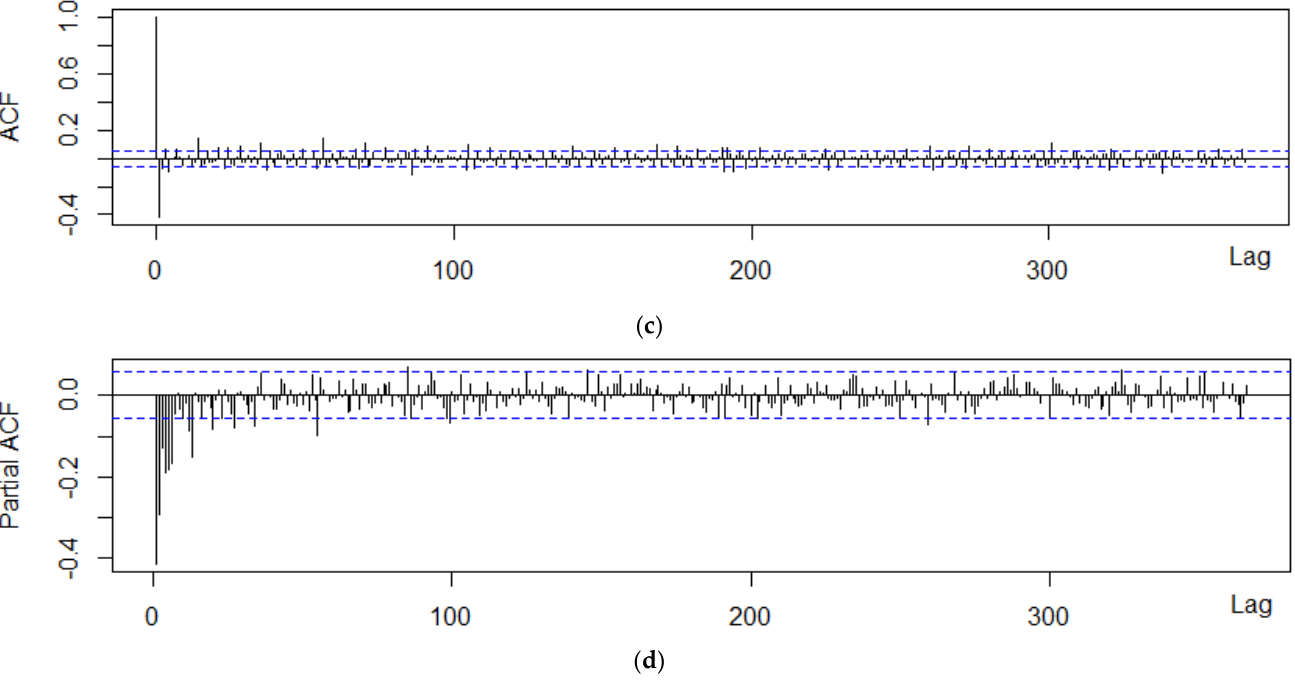
Figure A2. Autocorrelation function (ACF) of the Moran’s I b for Pasta prices of the original time series ( a ) and of the first differences ( c ); Partial autocorrelation function (PACF) of the Moran’s I b for Pasta prices of the original time series ( b ) and of the first differences ( d ). The Moran’s I b indexes are calculated based on binary contiguity matrices.